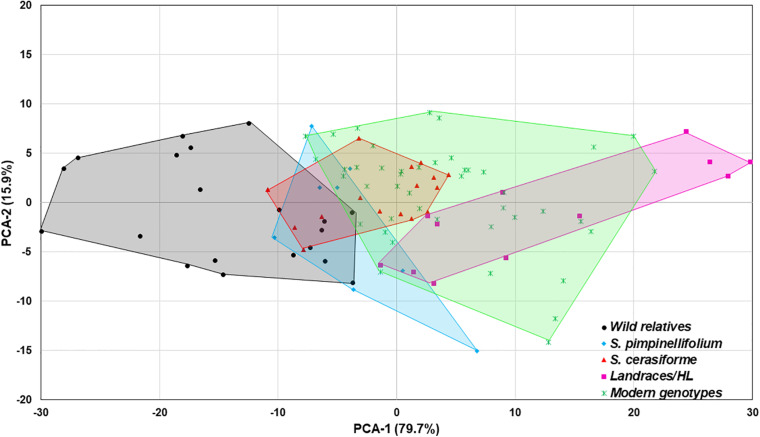
Principal component analysis (PCA) of all plant phenotype parameters. The percentage of variance explained by each component is displayed in parentheses. The wild relatives, Pimpinellifolium, S. cerasiforme wild tomato, landraces/heirloom and modern genotypes are depicted in black, light blue, green, dark blue, and orange, respectively.